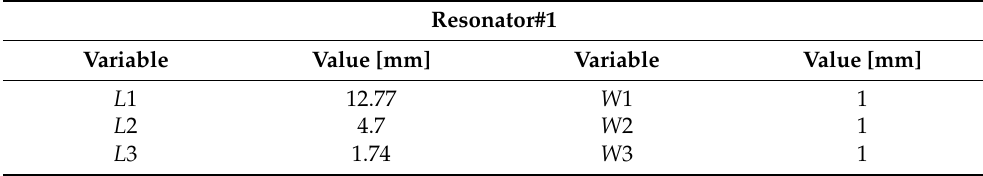
Figure 8. Prototyped eighth-order WG ZOR BPF via the CNC-milling process: ( a ) bird’s-eye view of the thin resonator with the round corners embedded in the flange body, ( b ) front view of the manufactured filter, ( c ) top view of the manufactured filter, ( d ) the device under test where the adaptors match with the flanges and ( e ) S 11 and S 21. Table 7. The values of the physical dimensions of the eighth-order filter, factoring in fabrication.